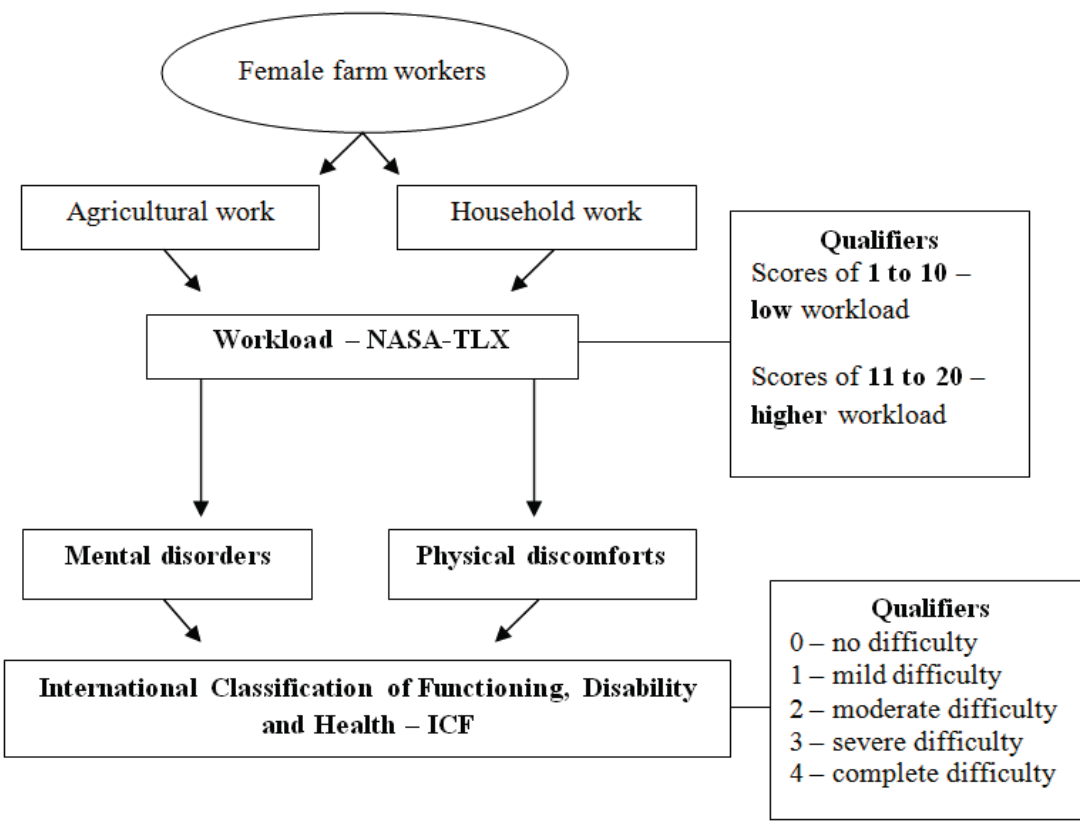
Figure 1. Characterization of agricultural and household demands, workload, mental disorders, and physical